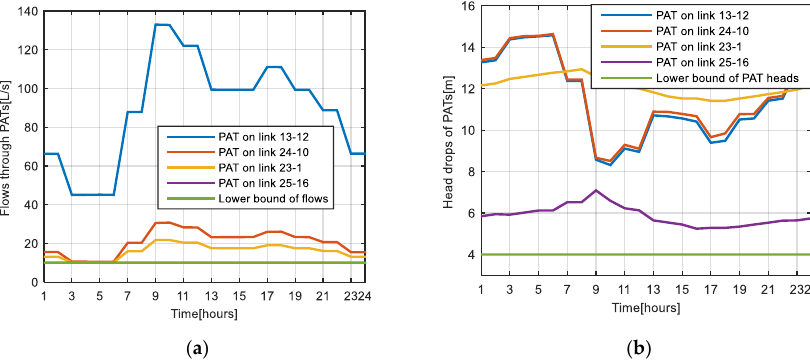
Figure 3. ( a ) Flows through PATs; ( b ) Head drops of PATs for 24 h (scenario 1).